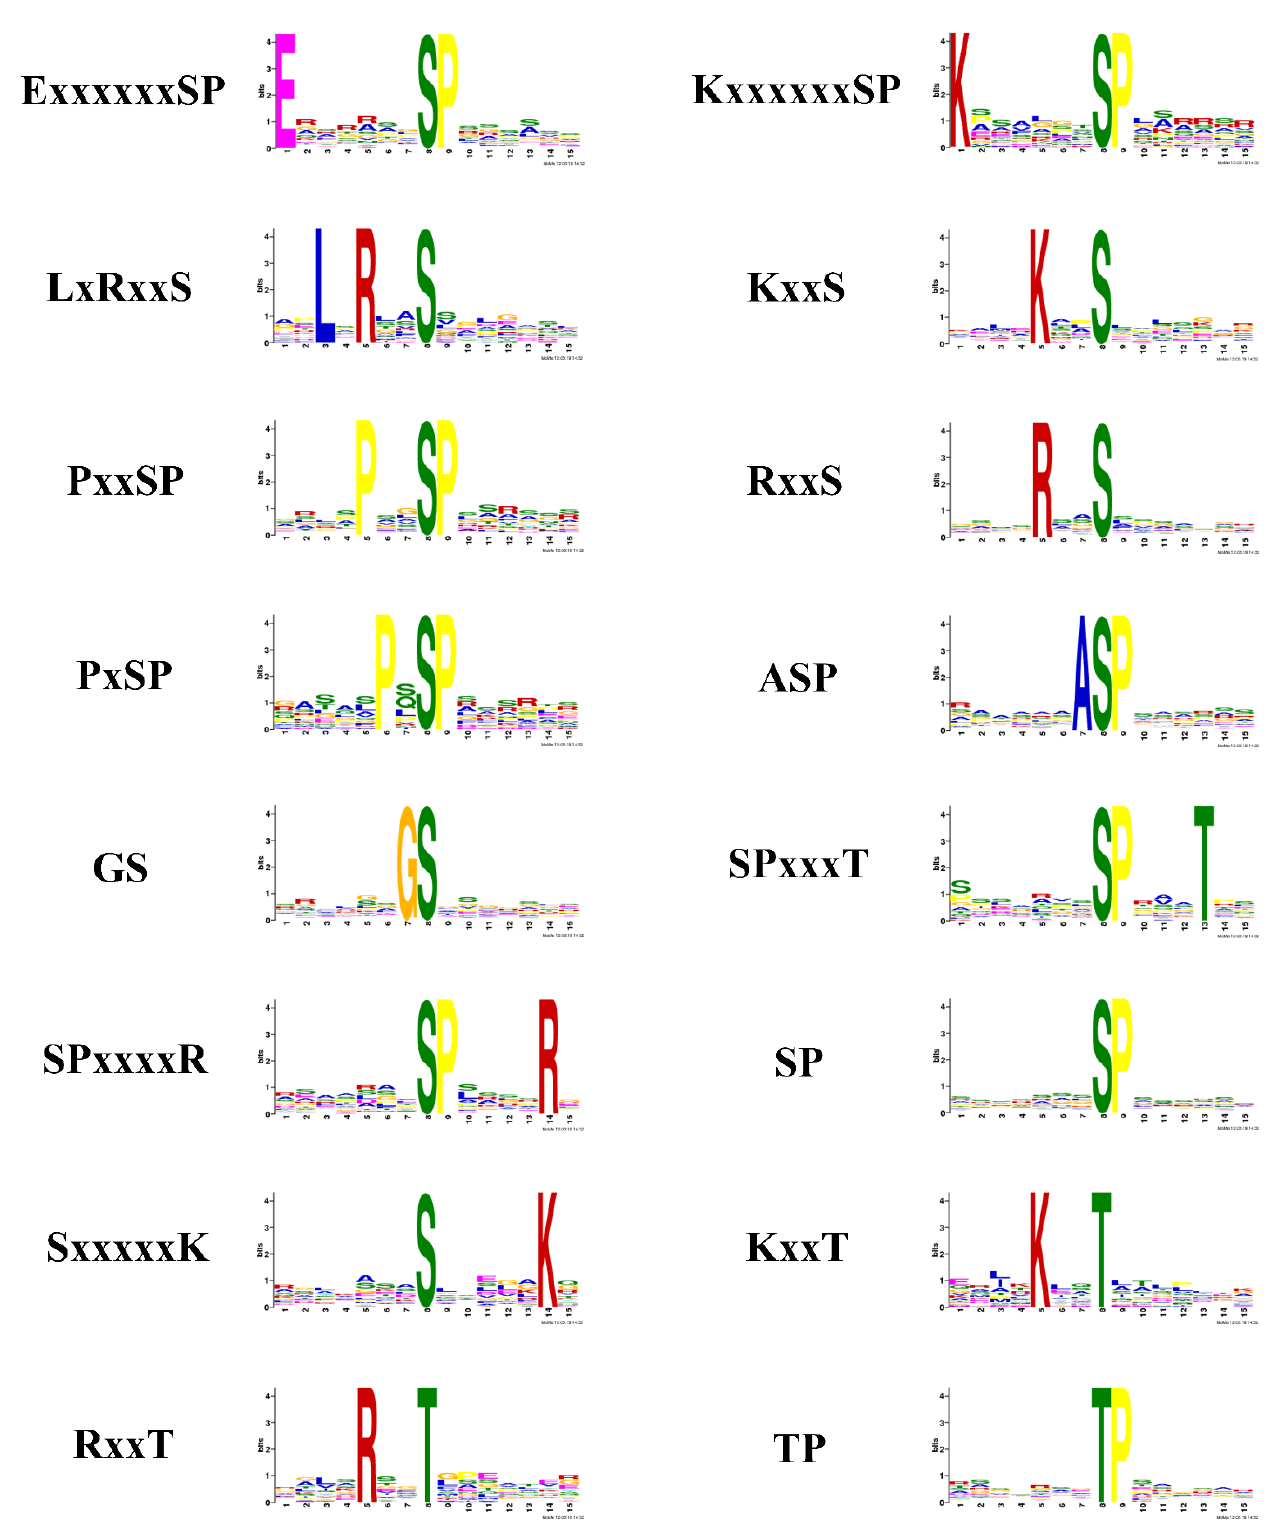
Figure 6. Phosphorylation site motif analysis of the downregulated DEPs using Motif-X. The degree of amino acids emerging at specific locations is represented by the elevation of the symbols.